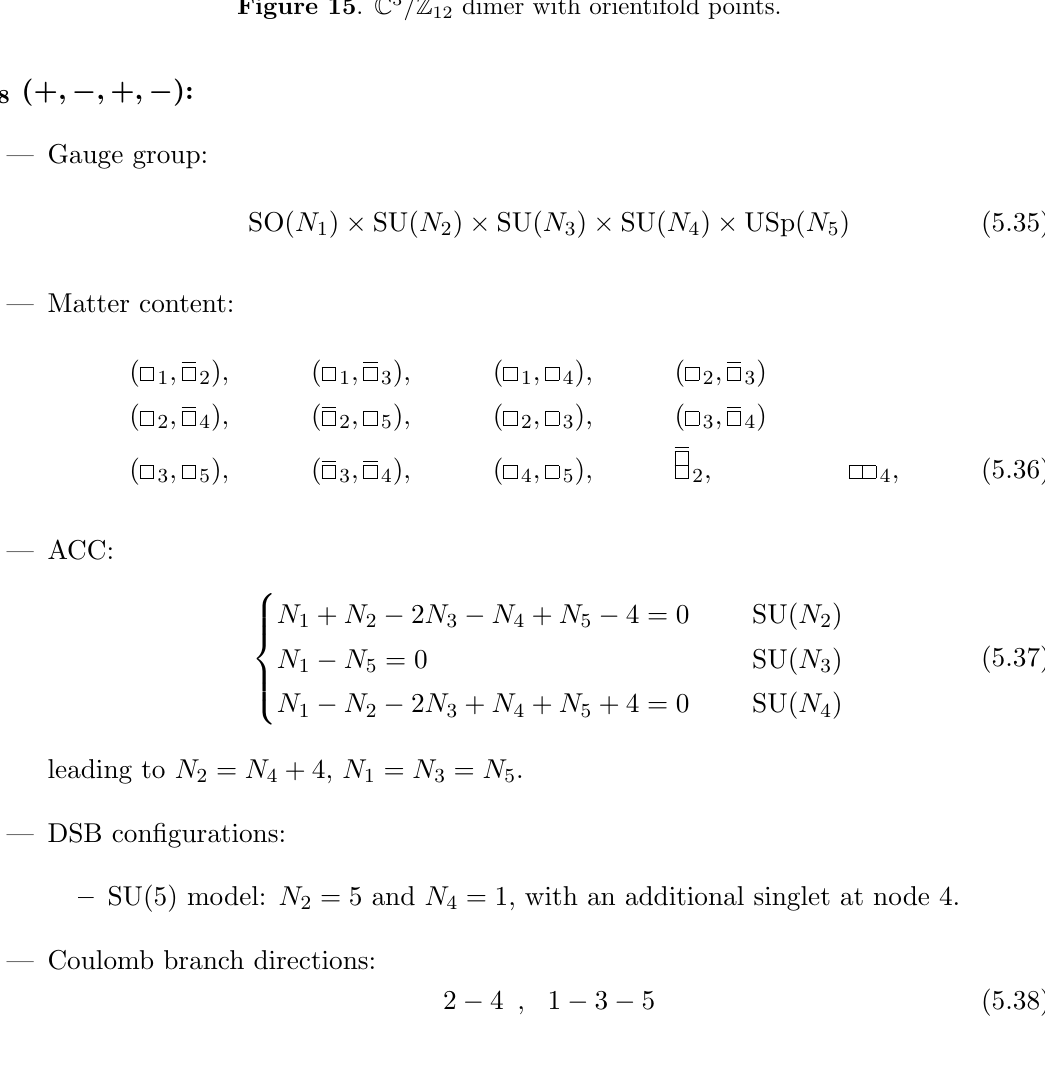
Figure 15 . C 3 = Z